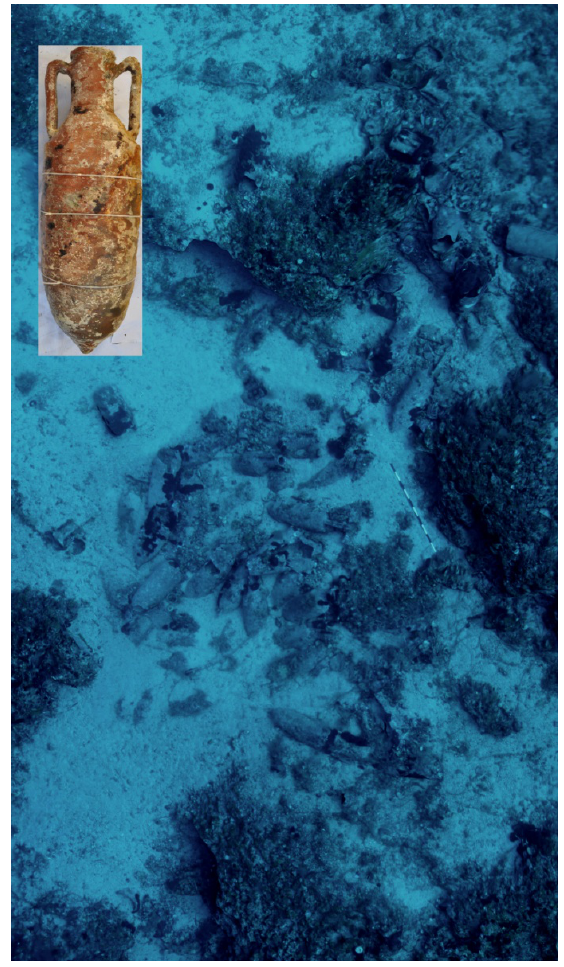
Figure 6: Detail of orthophotomosaic of wreck No.17 and